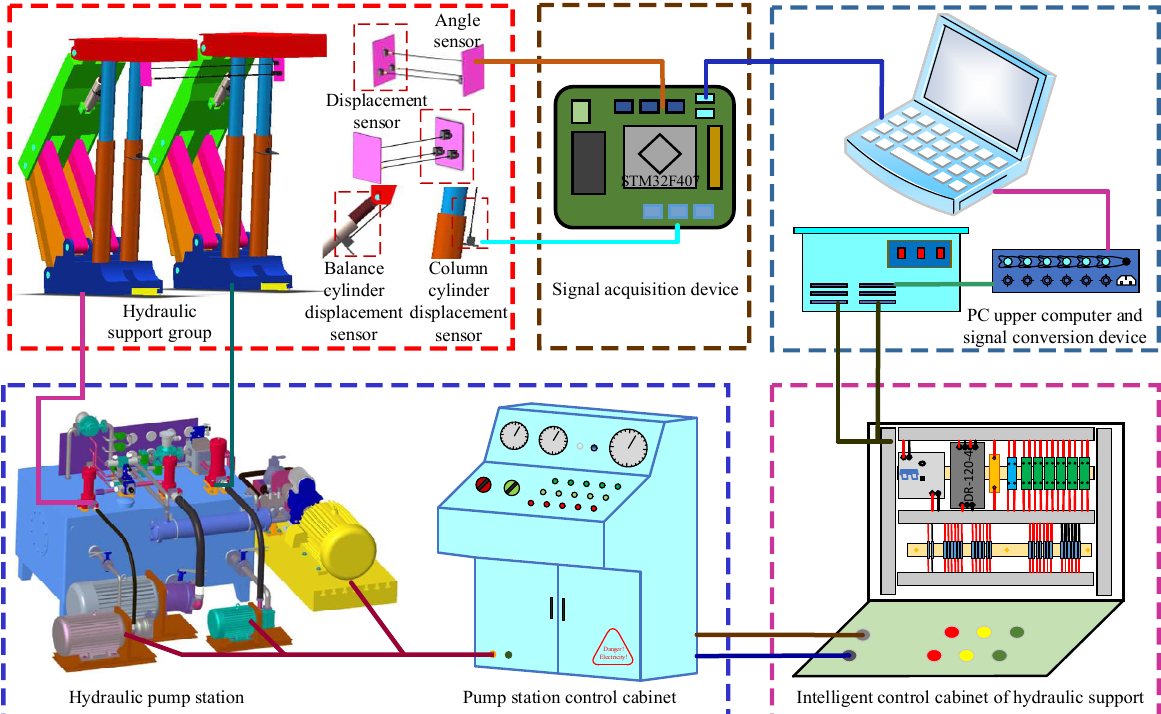
Figure 5. Schematic diagram of detection and control system of hydraulic support.